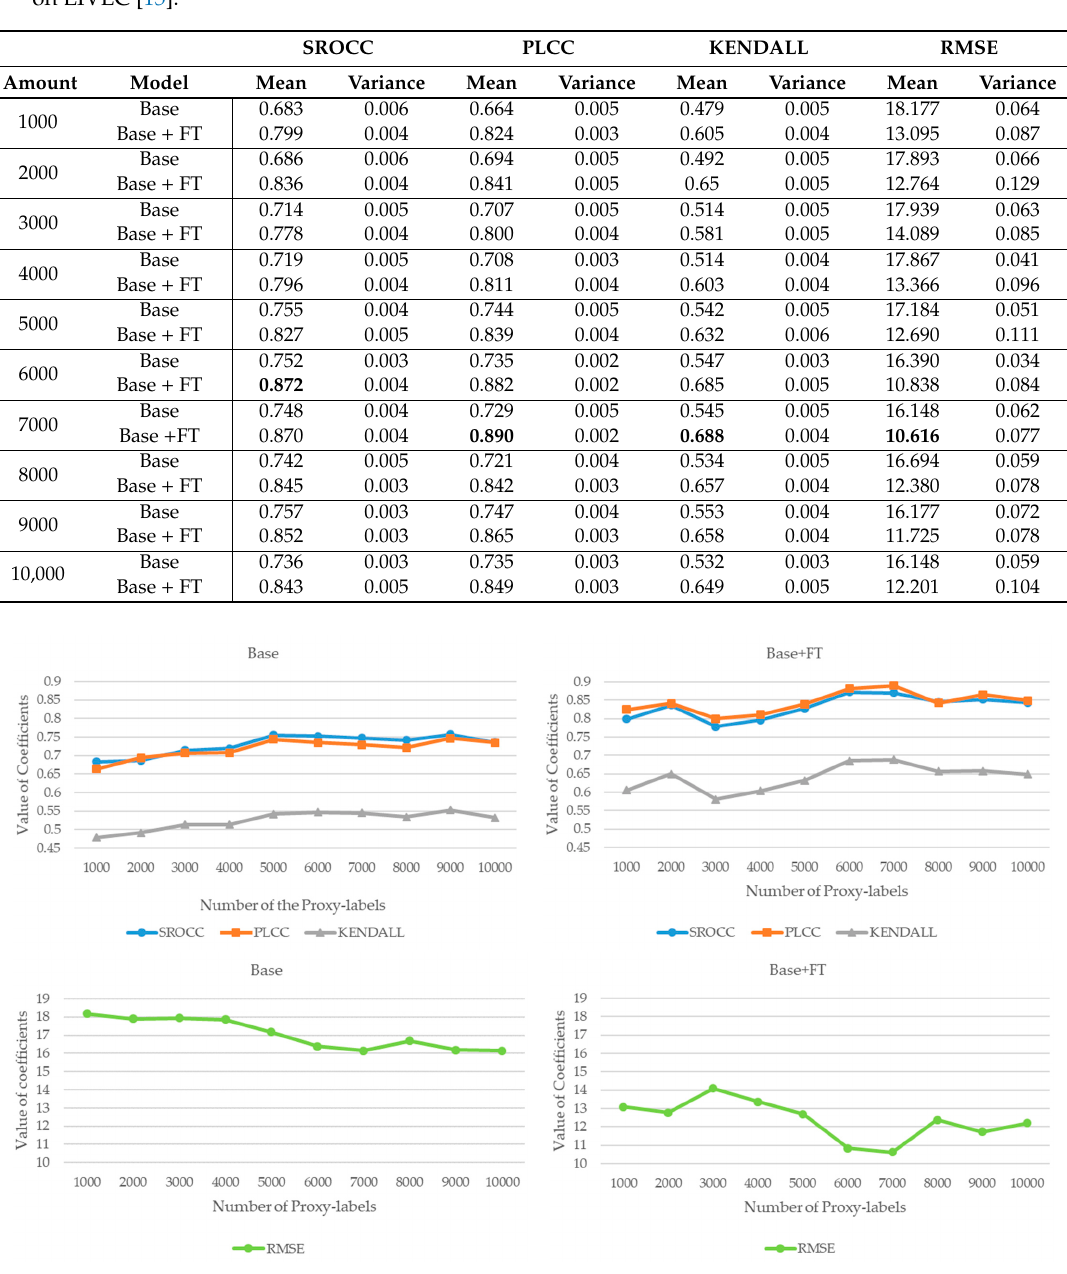
Figure 4. Trend of various coefficients based on different amounts of training data.